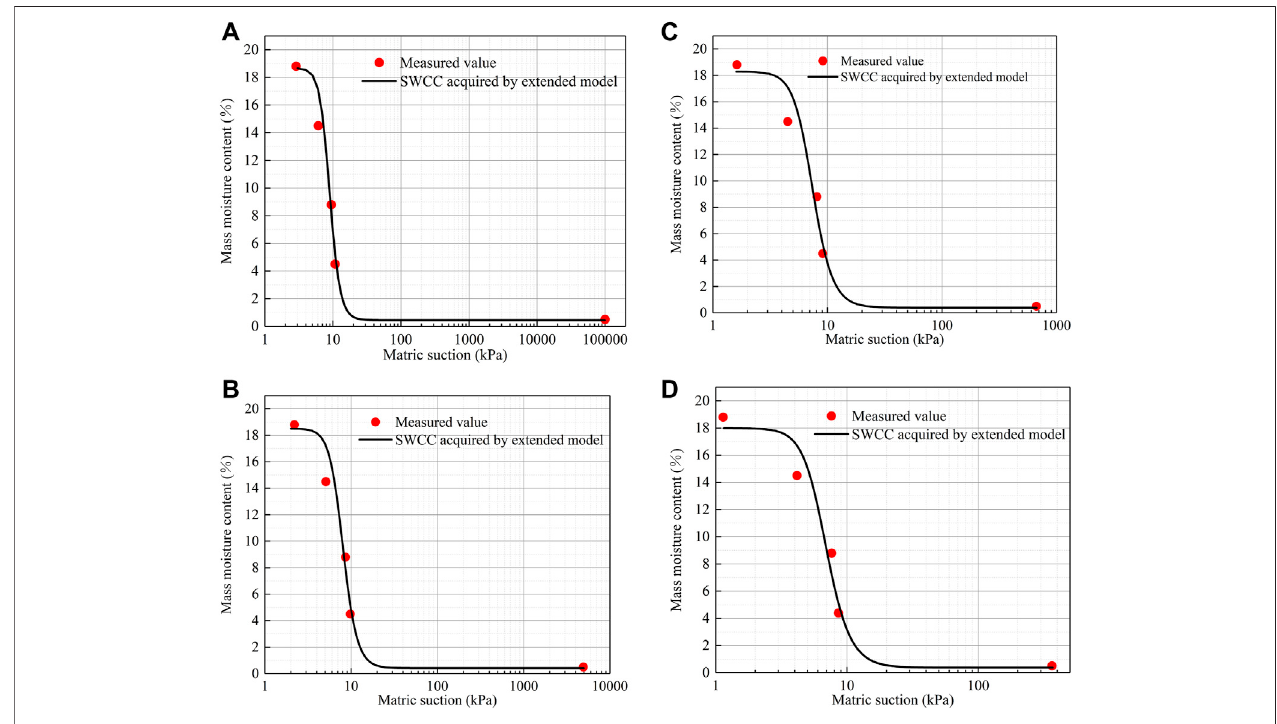
FIGURE 9 | Comparison between the measured value and SWCC acquired by extended model. (A) 10 ° C; (B) 20 ° C; (C) 30 ° C; (D) 40 ° C.